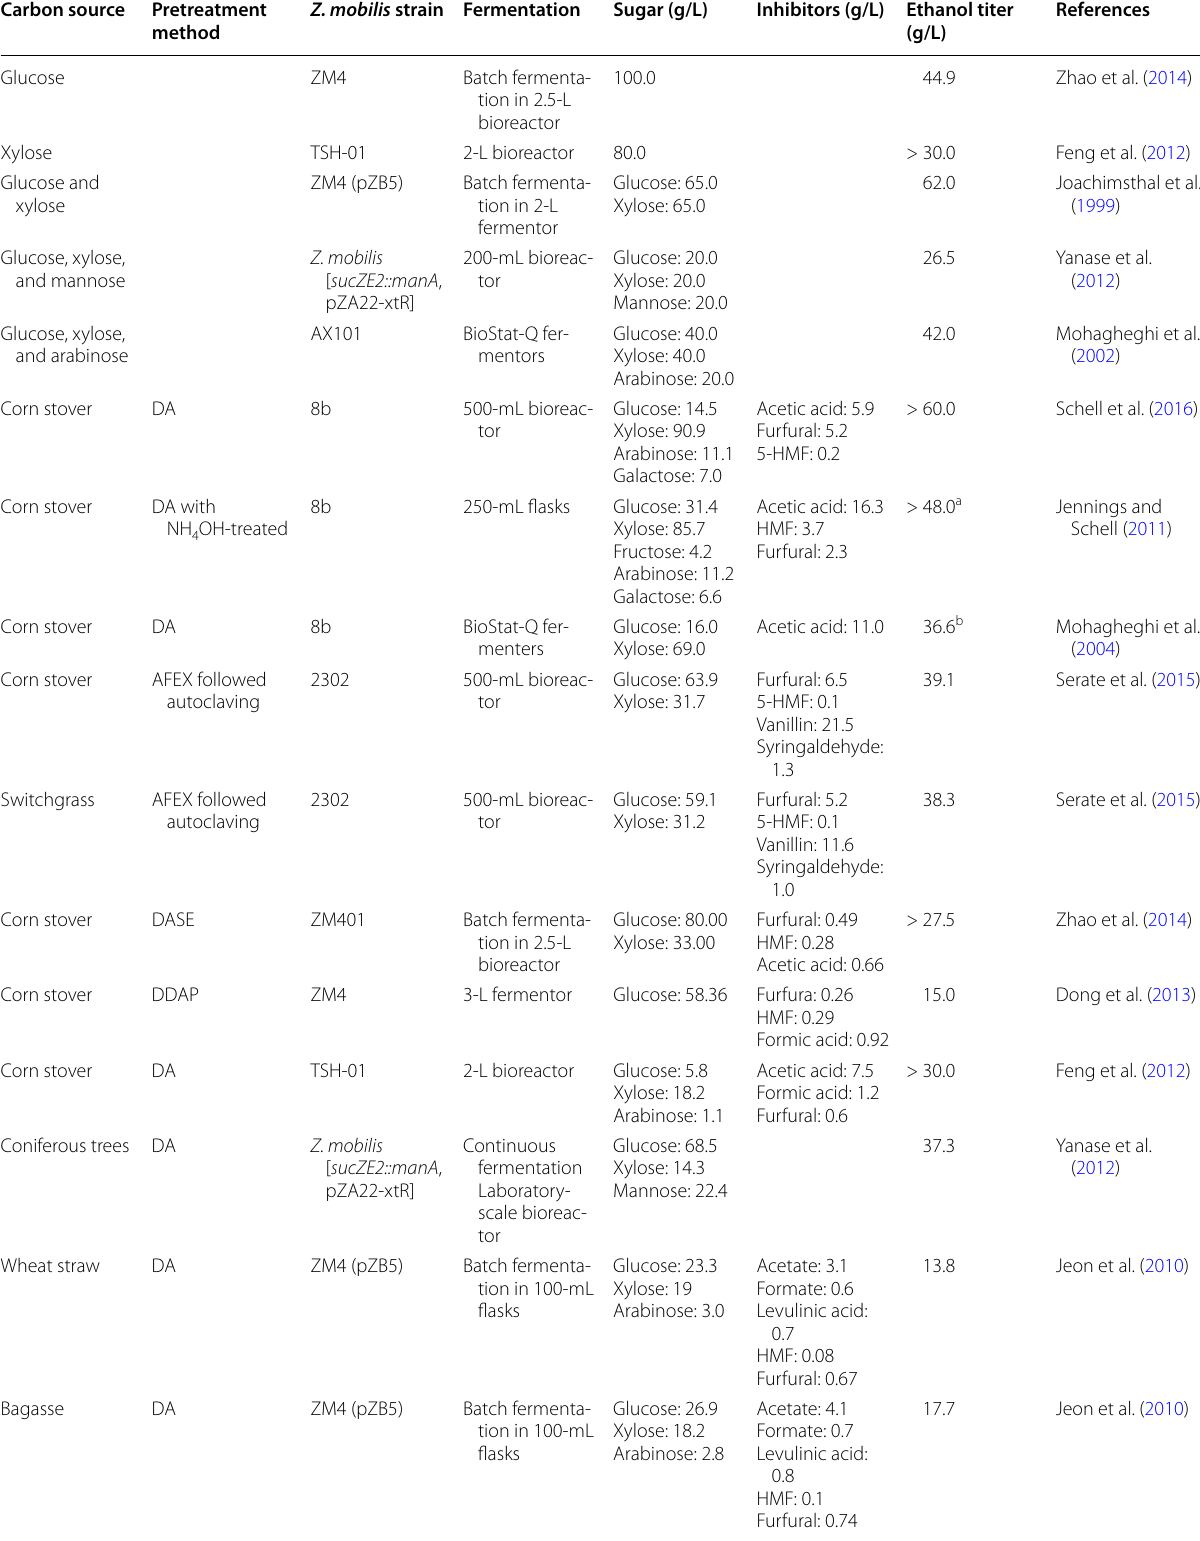
Table 1 Ethanol fermentation by Z . mobilis in lignocellulosic hydrolysates compared to pure sugars Carbon